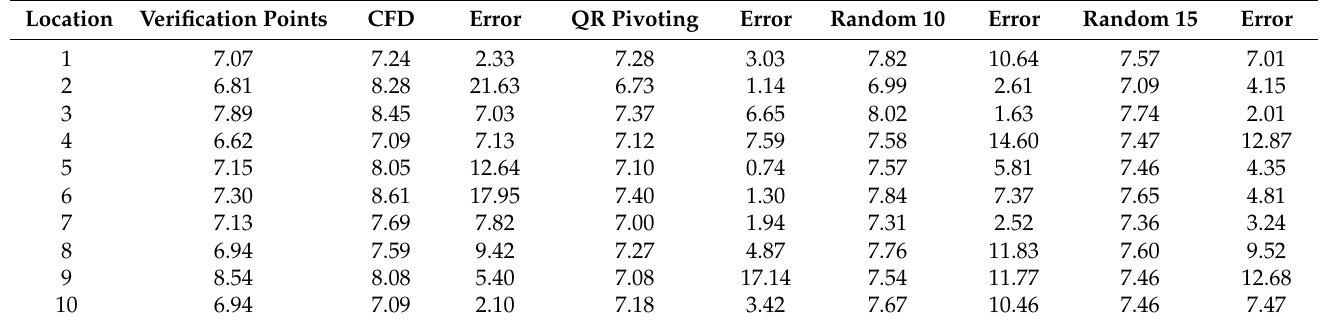
Table 9. Measured value (m/s), CFD value (m/s), reconstructed value (m/s) and error (%) of each location.